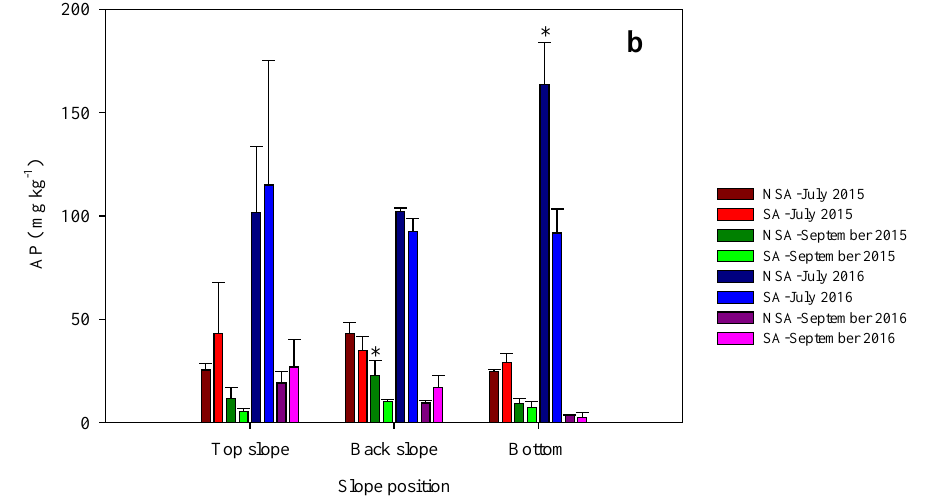
Figure 6. Soil available nitrogen (AN) (a) and soil available phosphorus (AP) (b)changed between the treatments in 2015 and 2016. Significantly differences between amendment and no straw amendment was marked with an “*” for the same slope position and year.